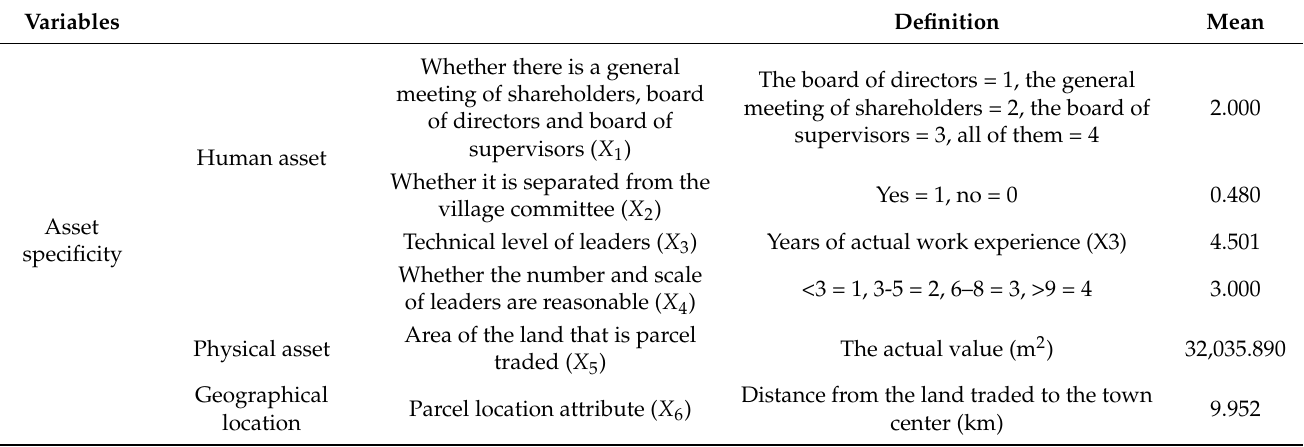
Table 1. Definitions of variables and description of